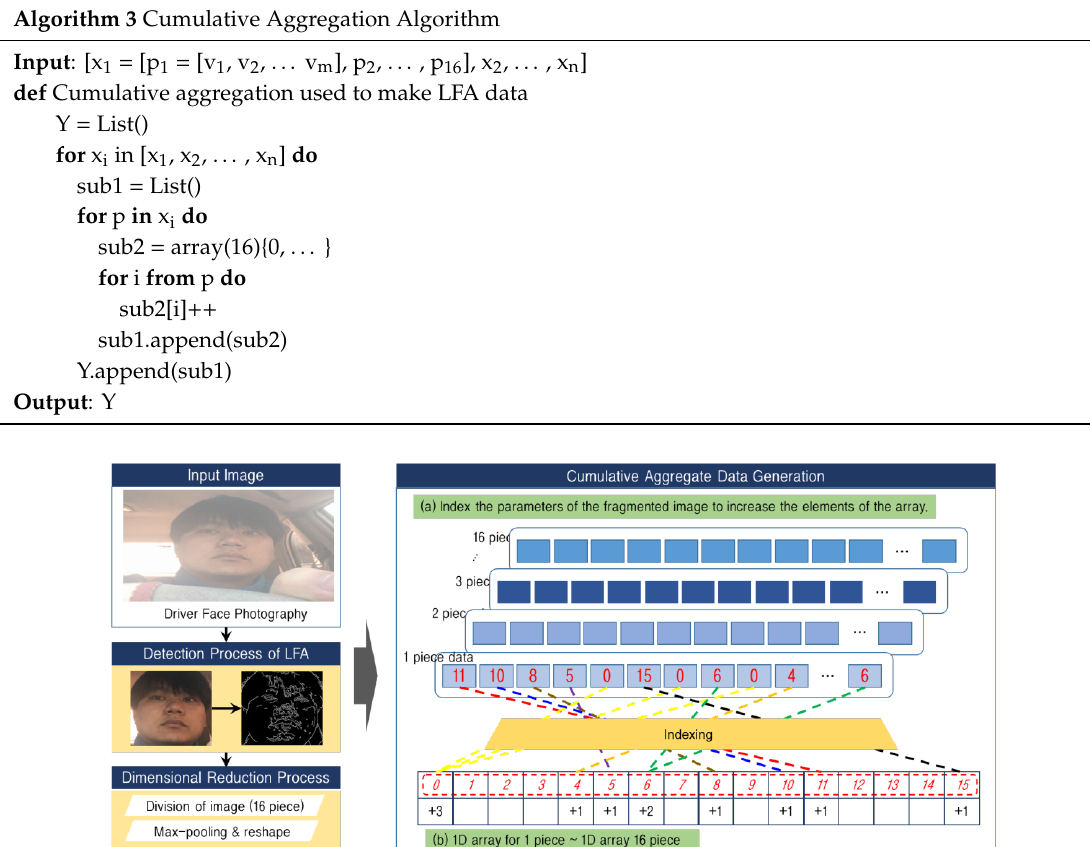
Algorithm 3 Cumulative Aggregation Algorithm